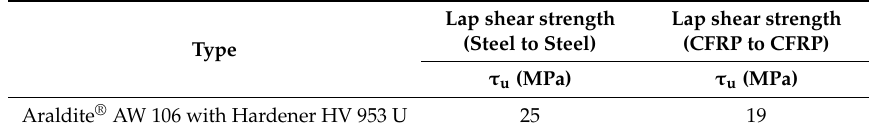
Table 4. Mechanical properties of adhesive at 23 ◦ C according to ISO 527 (from manufacturer’s data sheet).